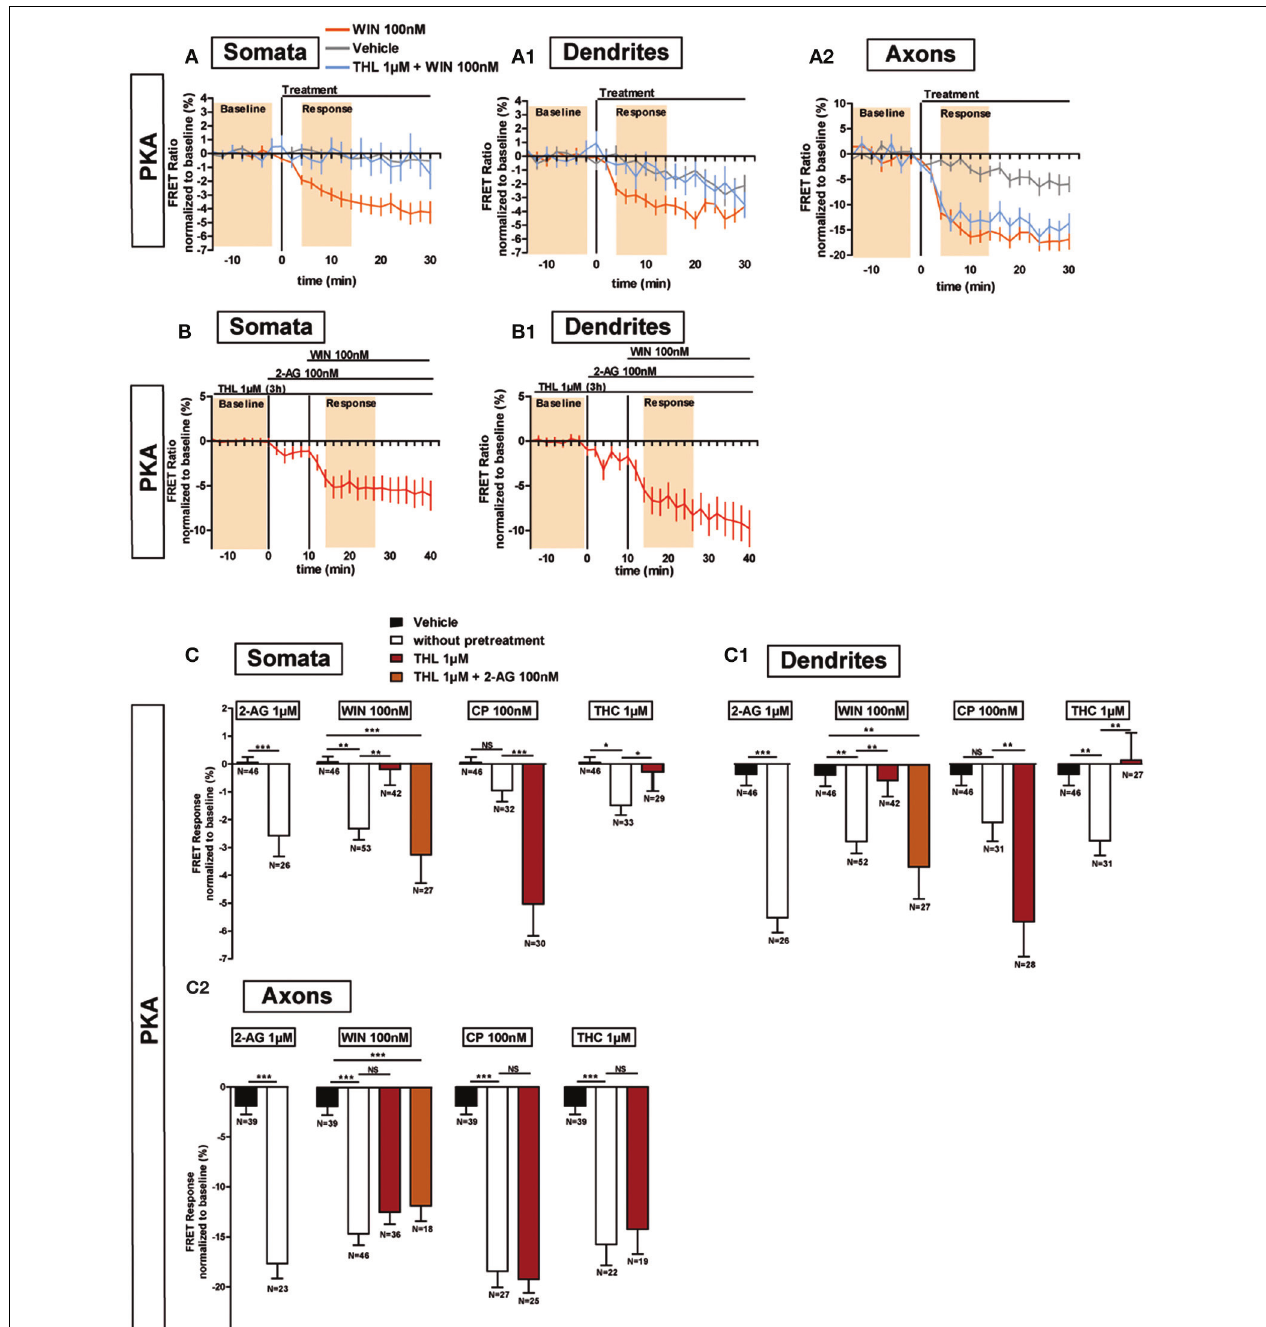
FIGURE 5 | Endogenous 2-AG significantly modifies CB1R responses to exogenous cannabinoids. (A,B) Averaged somatic, dendritic and axonal responses of AKAR4-Kras expressing neurons to agonist WIN 55-212,2 (WIN). The FRET ratio normalized to baseline was calculated for each neuron with a time-resolution of 2min. The curves represent mean ± S.E.M. of the FRET ratio for all imaged neurons at each time point. Addition of WIN 100nM but not of vehicle at t0 results in decreased PKA activity, which effect is significantly inhibited after DAGL inhibition by tetrahydrolipstatin (THL) 1 μ M in somata (A) and dendrites (A 1 ) but not in axons (A 2 ) . The effect of THL pre-treatment on the WIN effect in somata (B) and dendrites (B1) can be rescued by applying 2-AG at 100nM 10min before WIN. (C) Variation of